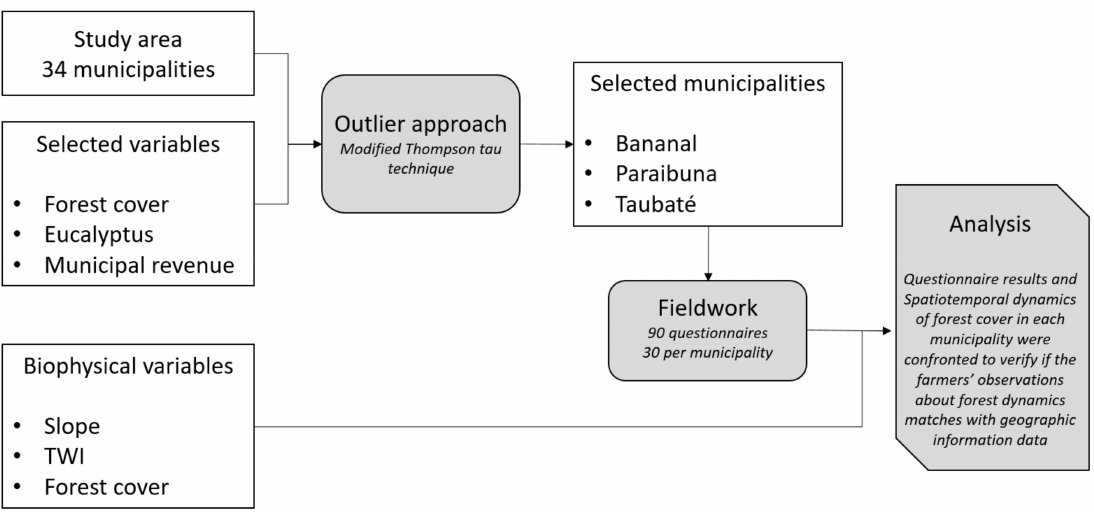
Figure 2. Methodological steps conducted to select study locations and to perform spatiotemporal analyses of land-use and land-cover changes with socioeconomic aspects of the Para í ba